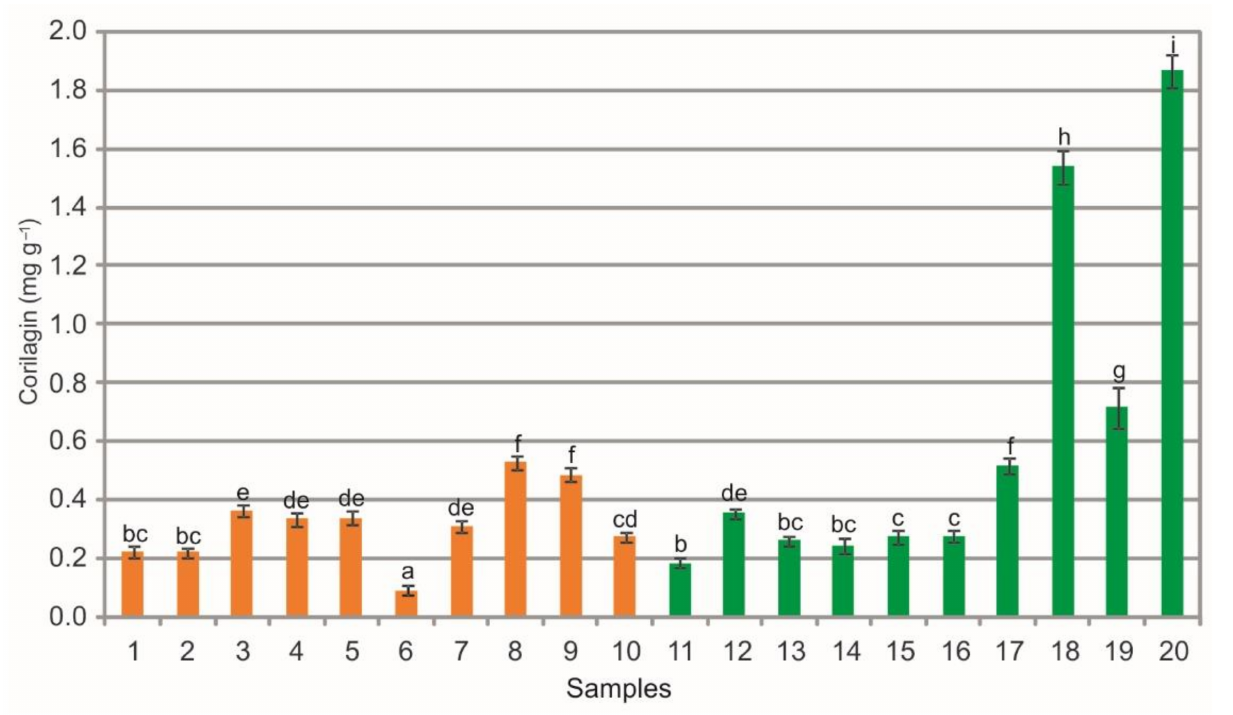
Figure 8. Corilagin contents (mg g − 1 ) in leaf extracts from bearberry plants collected in heathland populations (orange) and in pine forest populations (green). For each site, data are mean and SD. The values designated by the different letters are significantly different (U Mann-Whitney test, p <